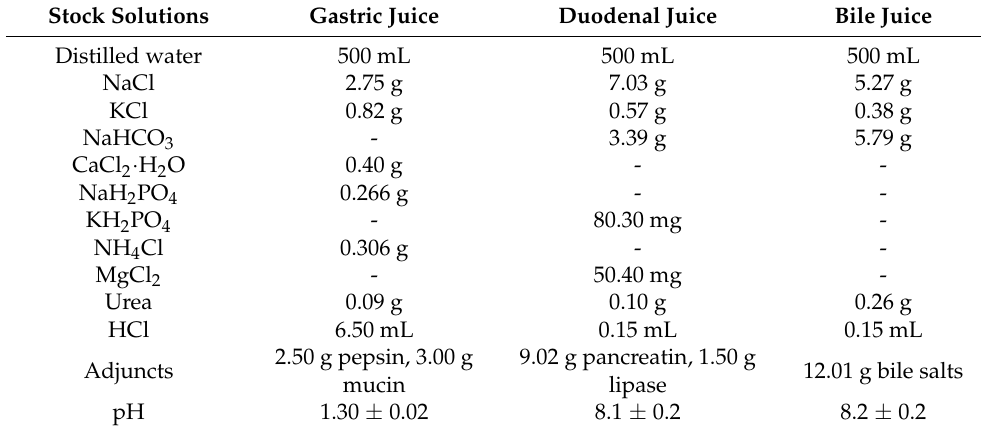
Table 1. Chemical composition of in vitro digestion